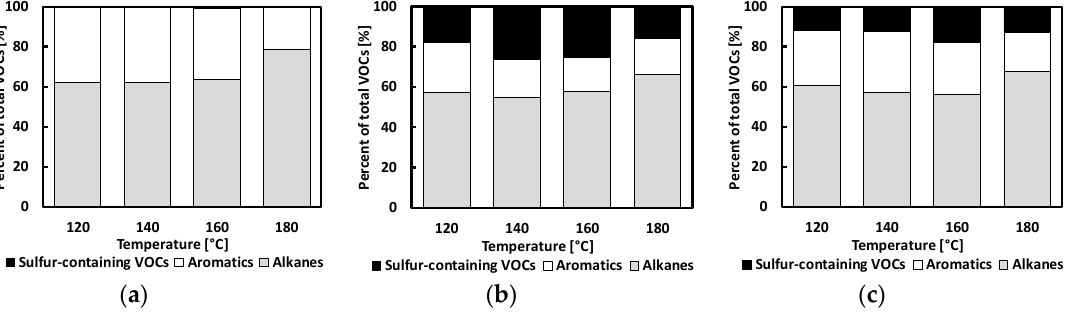
Figure 6. CR influence on the percentage of alkanes, aromatics and sulfur-containing VOC emission with a step-by-step increase in temperature: ( a ) REF, ( b ) CRMB1, and ( c ) CRMB2.